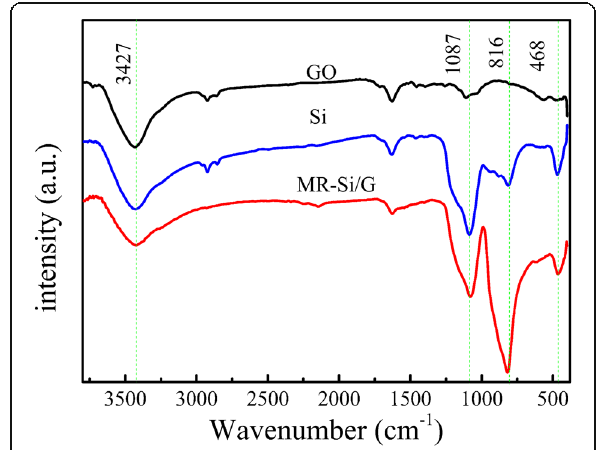
Fig. 4 FITR spectra of the GO, pure Si, and MR-Si/G composite